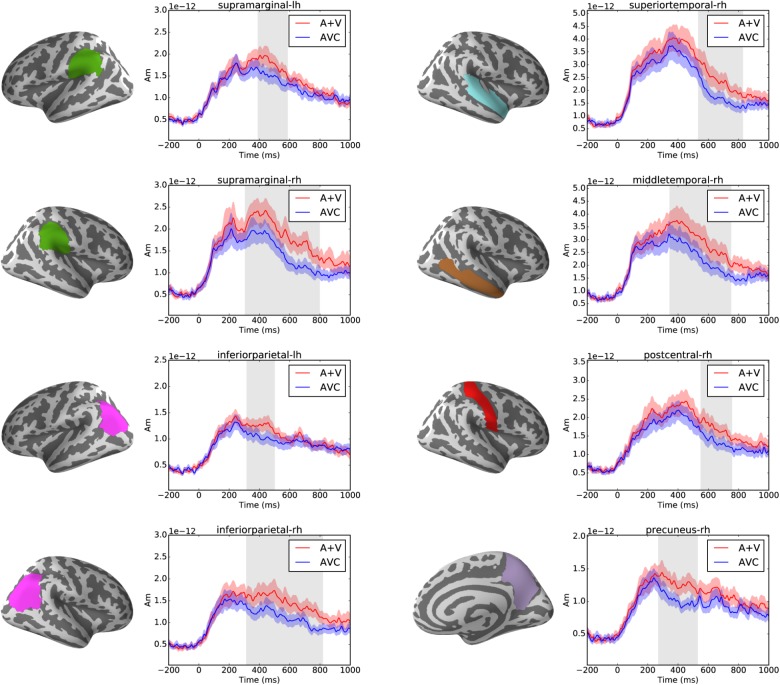
Left panels show the brain regions (as defined in the Desikan-Killiany atlas) that showed significant suppressive integration (A+V–AVC) effects. Right panels show the average source waveform (MNE estimate) extracted from the brain regions with significant clusters. The red and blue shading represent the standard error of the mean and the gray shadings show the time window of the significant cluster.